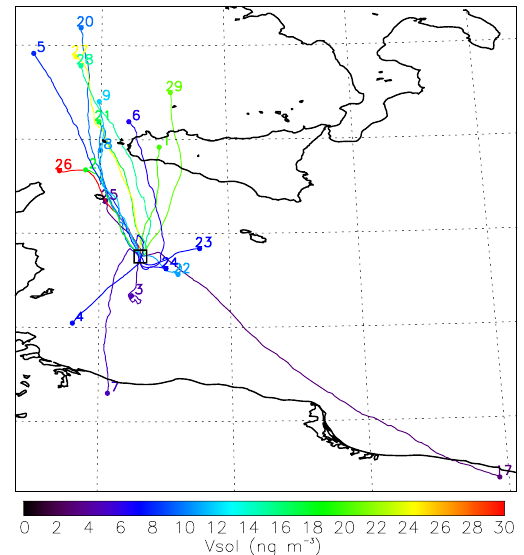
Fig. 7. 18-h back trajectories for the 20 June–9 July 2008 period, when only 3 daily V sol measurements (25 June, 3 and 7 July) were below V st . The 24-h back trajectory of 17 May is also presented. The number at the end of each back-trajectories indicates the corre- sponding day of June and